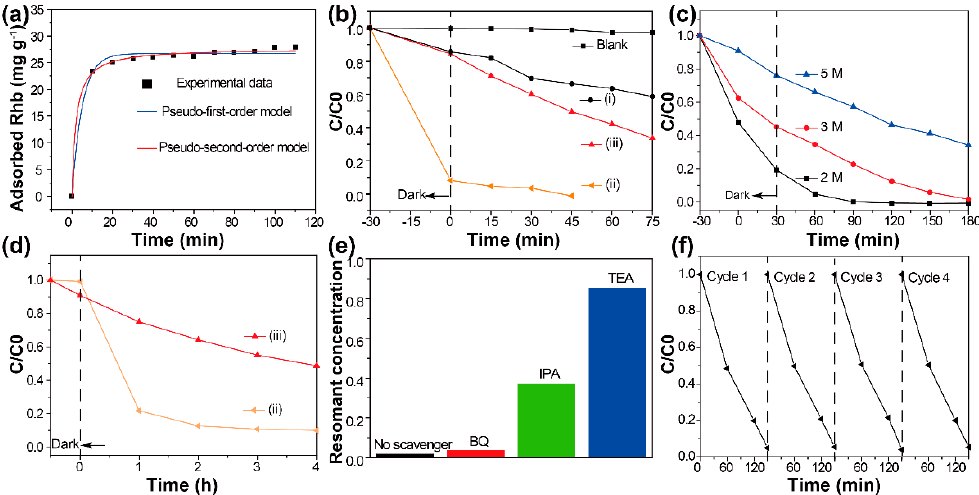
Figure 4. ( a ) Kinetics of Rhodamine B (RhB) adsorption onto the BiOCl/Bi 2 WO 6 hybrids. ( b ) Removal of RhB solution (1 M) with time over the as-prepared samples: (i) BiOCl, (ii) BiOCl/Bi 2 WO 6 hybrids and (iii) Bi 2 WO 6 . ( c ) The photocatalytic activity of the RhB solution with different concentrations over the BiOCl/ Bi 2 WO 6 hybrids: 2 M, 3 M and 5 M, respectively. ( d ) The photocatalytic degradation of ciprofloxacin (CIP) solution by (ii) BiOCl/Bi 2 WO 6 hybrids and (iii) Bi 2 WO 6 . ( e ) Reactive species trapping experiments and ( f ) Stability experiment of BiOCl/Bi 2 WO 6 hybrids: RhB solution (2 M).